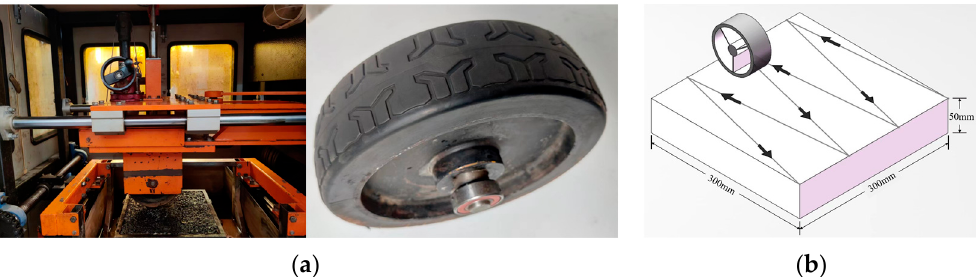
Figure 2. Accelerated pavement test: ( a ) kneading machine and tire and ( b ) tire kneading path.